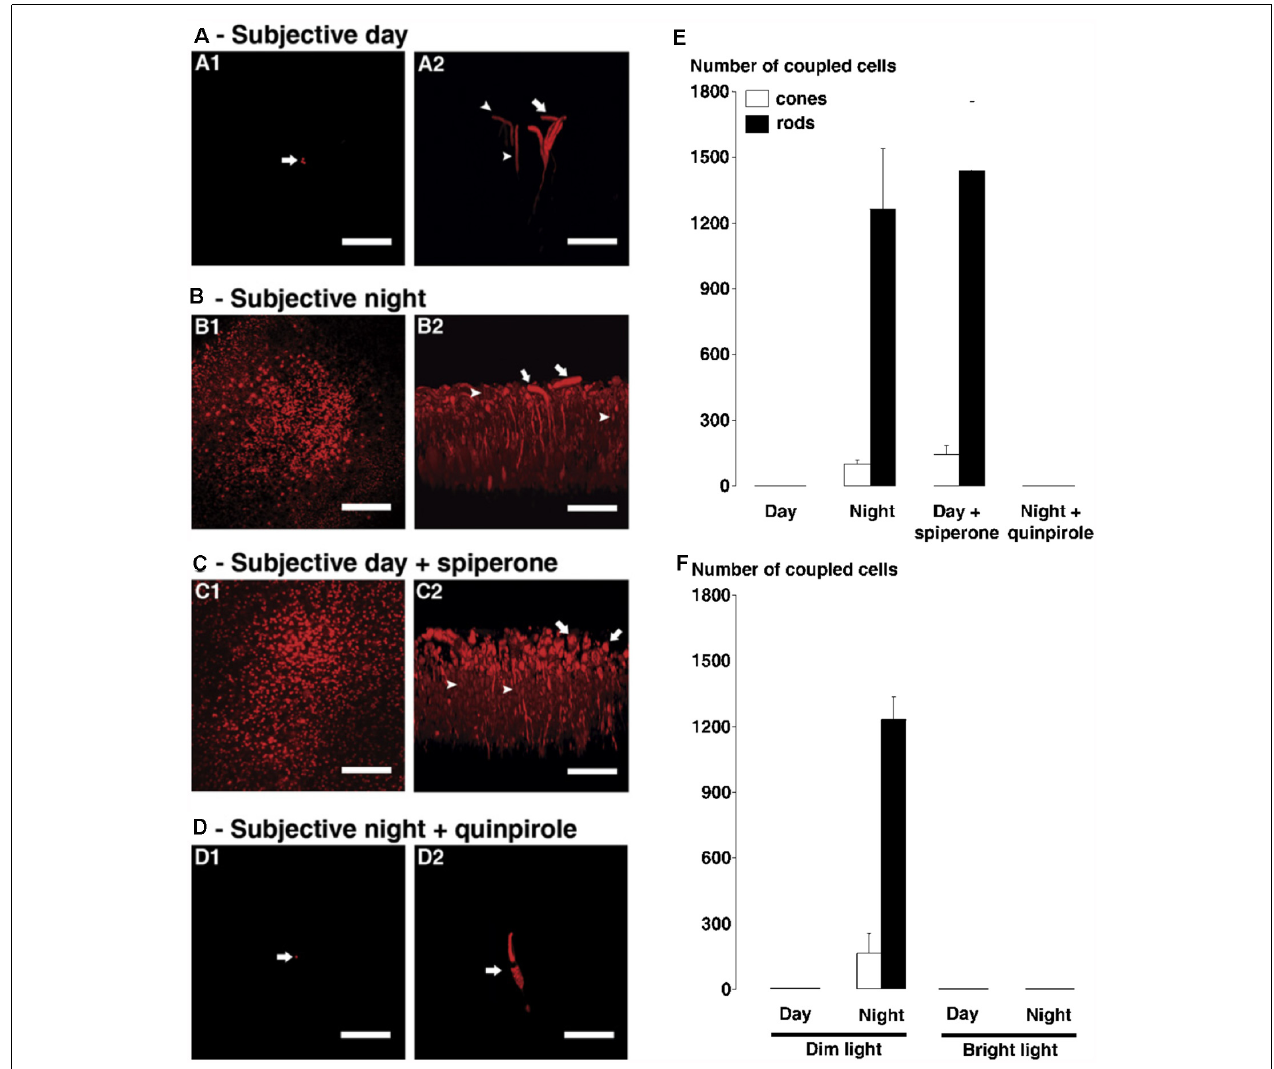
FIGURE 11 | The circadian clock in the goldfish retina controls rod-cone tracer coupling by activating dopamine D 4 receptors in the day but not at night. (A–D) Following iontophoresis of biocytin into individual cones in intact neural goldfish retina, tracer remained in a few cells (indicated by arrows) near the injected cone during the subjective day (A) and during the subjective night in presence of D 4 receptor agonist quinpirole (1 µ M, D ). It diffused into many rods and cones during subjective night (B) and during subjective day in the presence of D 4 receptor antagonist spiperone (10 µ M, C ). In each of (A–D) , confocal images of a whole-mount retina at the level of the rod inner segments are shown on the left (A1–D1) and perpendicular views of the 3-D reconstruction of the photoreceptor cells from the same retina are shown on the right (A2–D2) . Some cones and rods are indicated by arrows and arrowheads, respectively. Scale bars (A–D) : 50 µ m. (E,F) Average numbers of stained cones (open bars) and rods (filled bars) following biocytin injections into individual cones (1 cone injected/retina) under dark-adapted (E) and light-adapted (F) conditions are shown. (E) Under dark-adapted conditions ( > 60 min), the number of tracer coupled rods and cones was significantly greater during the night and during the day following spiperone treatment than during the day under control conditions. (F) Under dim light-adapted conditions (i.e., − 5 log I o , 500 ms light flashes at 0.125 Hz for > 60 min), the number of tracer-coupled rods and cones was significantly greater during the night compared to the day (i.e., results are similar to those obtained in the dark). In contrast, under bright light-adapted conditions (i.e., − 2 log I o , 500 ms light flashes at 0.125 Hz for > 60 min) in day and night, biocytin was restricted to the injected cone; no other cells were labeled. Error bars represent SEM. Modified from Ribelayga et al.